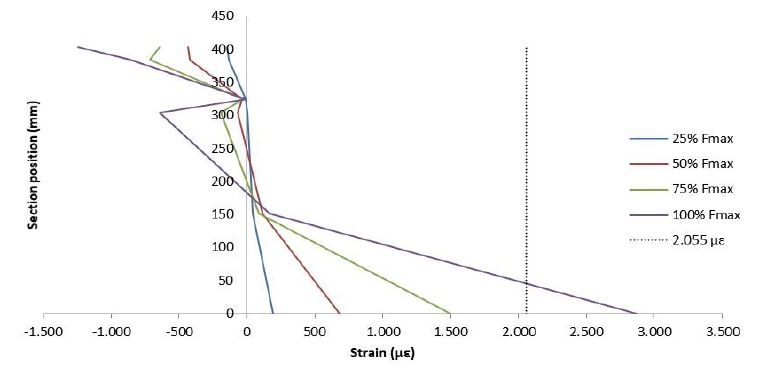
Figure 20. Strain distribution curve – V1A.